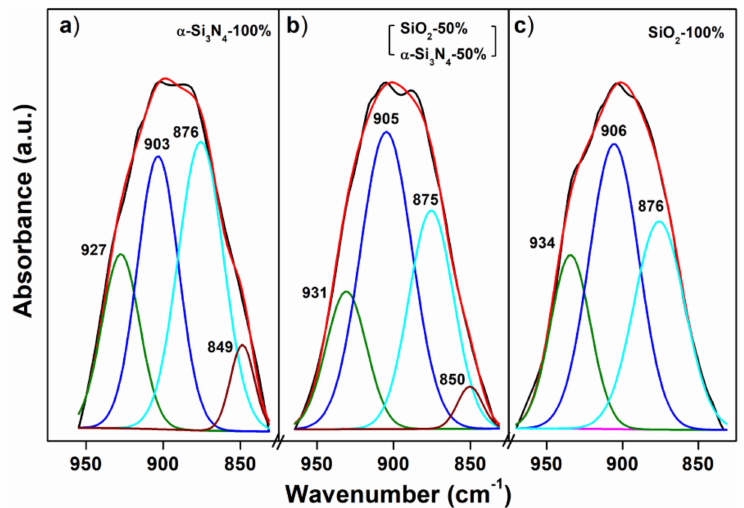
Figure 5. Gaussian fitting of vibration bands of BSO:Eu 2 + and BSON:Eu 2 + phosphor between 830 and 970 cm − 1 : α -Si 3 N 4 –100% ( a ), SiO 2 –50% and α -Si 3 N 4 –50% ( b ), SiO 2 –100% ( c